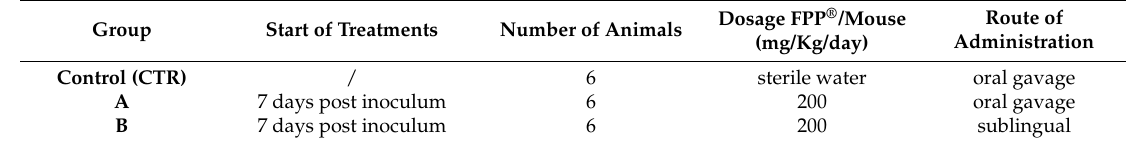
Table 2. Experimental scheme of third experiment in C57/Bl mice treated with FPP ® .